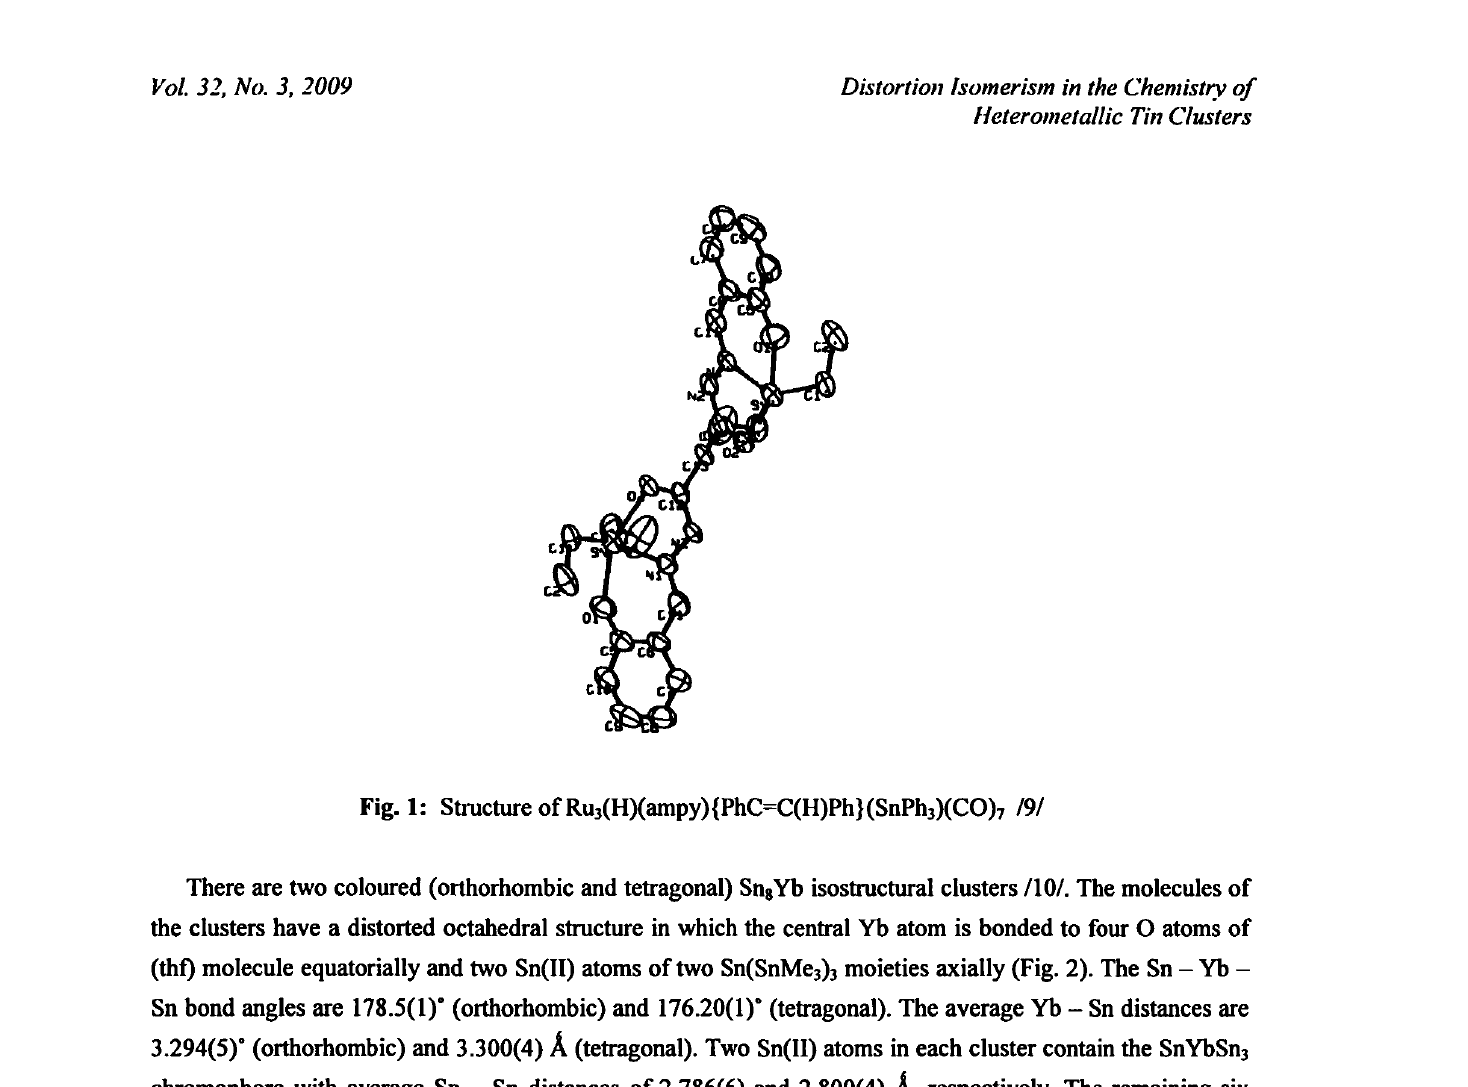
Fig. 1: Structure of Ru (H)(ampy){PhC=C(H)Ph}(SnPh )(CO) /9/ 3 3 7 There are two coloured (orthorhombic and tetragonal) Sn Yb isostructural clusters /10/. The molecules of 8 the clusters have a distorted octahedral structure in which the central Yb atom is bonded to four Ο atoms of (thf) molecule equatorially and two Sn(II) atoms of two Sn(SnMe ) moieties axially (Fig. 2). The Sn - Yb - 3 3 Sn bond angles are 178.5(1)° (orthorhombic) and 176.20(1)° (tetragonal). The average Yb - Sn distances are 3.294(5)° (orthorhombic) and 3.300(4) A (tetragonal). Two Sn(II) atoms in each cluster contain the SnYbSn 3 chromophore with average Sn - Sn distances of 2.786(6) and 2.800(4) A, respectively. The remaining six Sn(II) atoms in each of the respective clusters contain the SnC Sn chromophore. 3